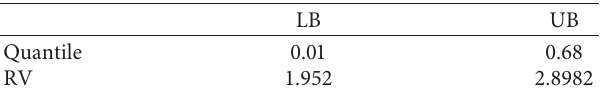
Table 23: The values of the optimal lower bound and upper bound for grid optimization and the values in the corresponding RV